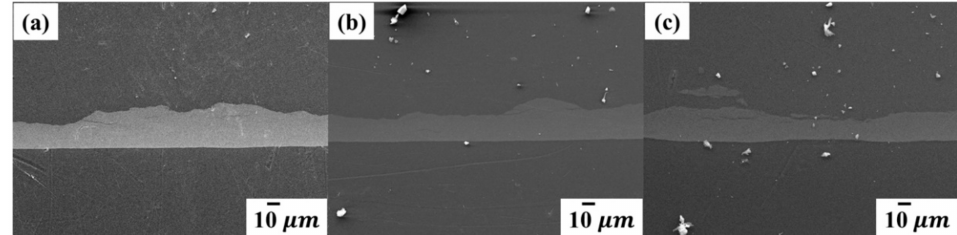
Figure 5. FE-SEM images of the cross-section of the fabricated superhydrophobic coated films with relative SNP weight ratios of ( a ) 100%, ( b ) 33%, and ( c ) 11%. Additionally, the line EDS was used for the chemical composition on the PP/SNPs coated film. As shown in Figure 6, the PP/SNPs coated film with 100% relative weight ratio of SNPs is composed of carbon, oxygen, and silicon elements, and the chemical compositions of the film were clearly different from the base PP layer and the mounting material layer. All the samples with different weight ratios showed similar